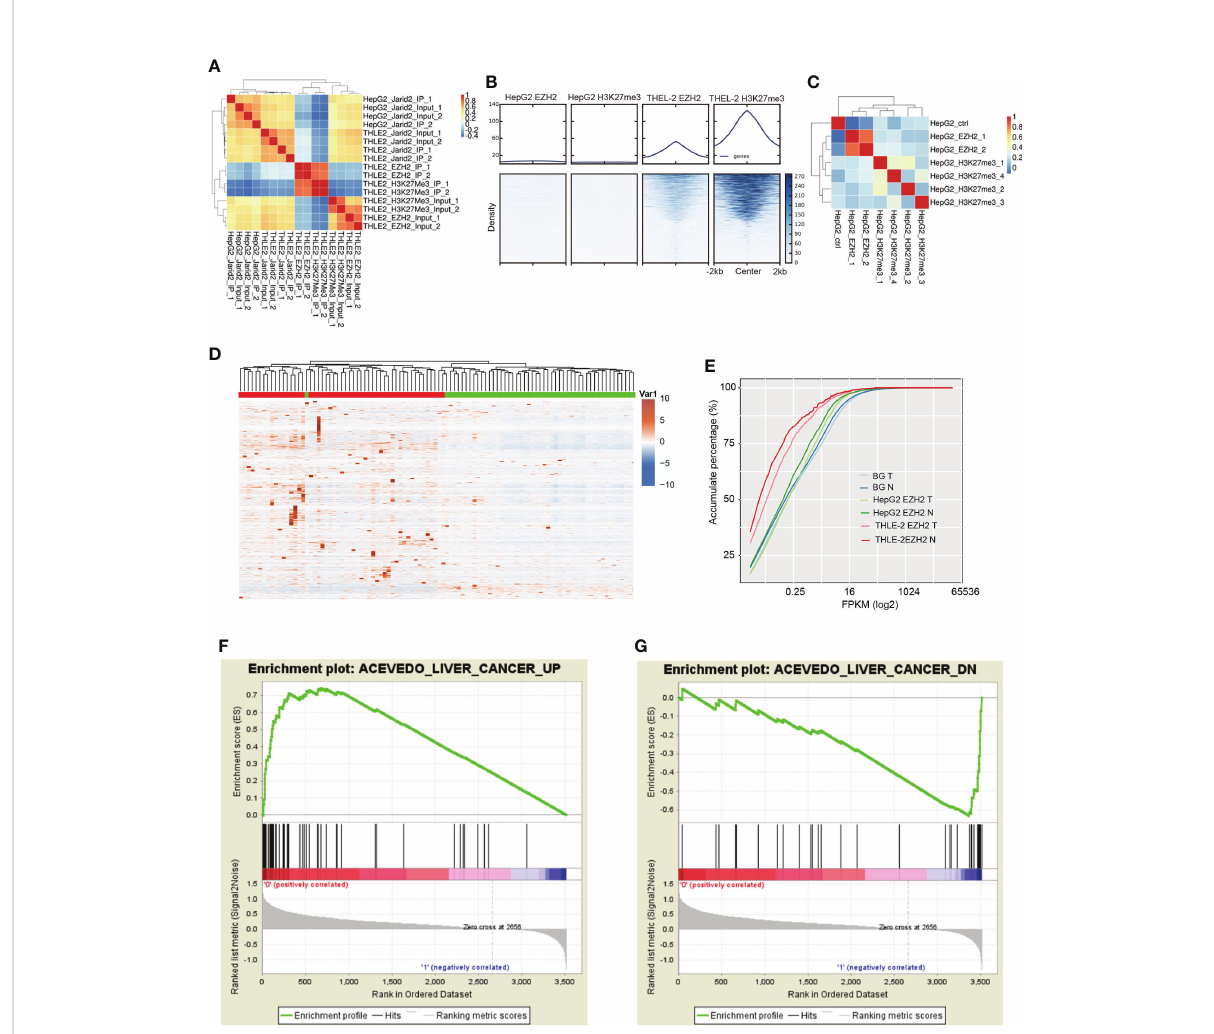
FIGURE 4 ChIP-seq results showing that EZH2 could increase the expression level of bound genes. (A) Hierarchical clustering sample correlation showing that EZH2 and H3K27me3 binding pro fi le were highly correlated in THLE-2 cells. (B) Heatmap presentation of ChIP-seq samples reads density around the center of peaks from THLE-2 EZH2 and H3K27me3 samples. (C) Hierarchical clustering sample correlation showing that EZH2 and H3K27me3 binding pro fi le were lowly correlated in HepG2 cells. (D) Hierarchical clustering heatmap showing the expression pattern of genes speci fi cally bound by EZH2 in HepG2 cells compared with THLE-2 cells. The expression levels of genes were obtained from the TCGA database. The samples with the green bar were adjacent normal samples, and the samples with the red bar were HCC tumor samples. (E) Accumulative plot showing the expression pattern of speci fi cally EZH2-bound genes in HepG2 or THLE-2 cells from ChIP-seq results, as well as all the expressed genes. (F) GSEA analysis result showing the enriched gene set for top ranked genes speci fi cally bound by JARID2 in HepG2 cells compared with THLE-2 cells. (G) GSEA analysis results showing the enriched gene set for bottom-ranked genes speci fi cally bound by JARID2 in HepG2 cells compared with THLE-2